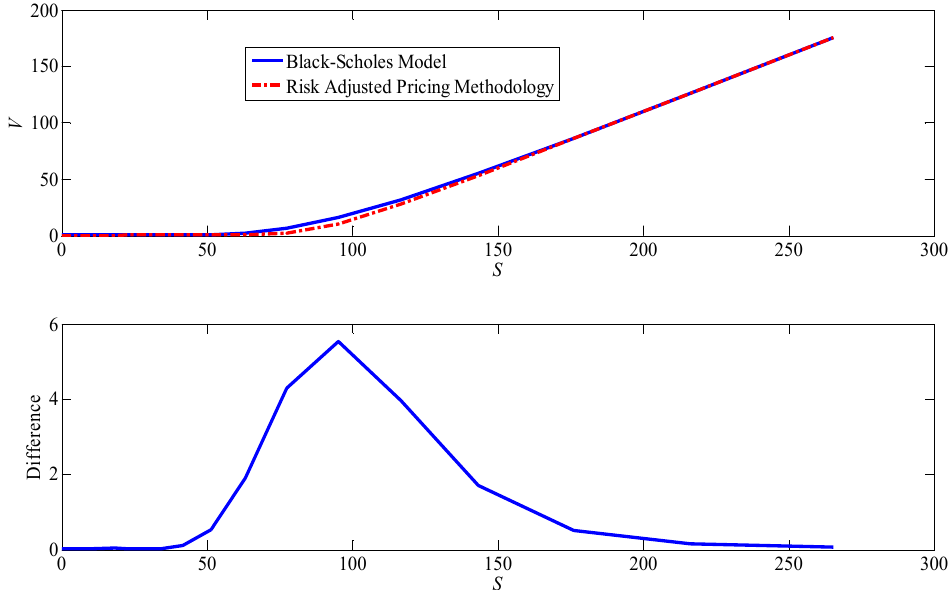
Figure 5. Difference of call option price between Black–Scholes model and risk adjusted pricing methodology.